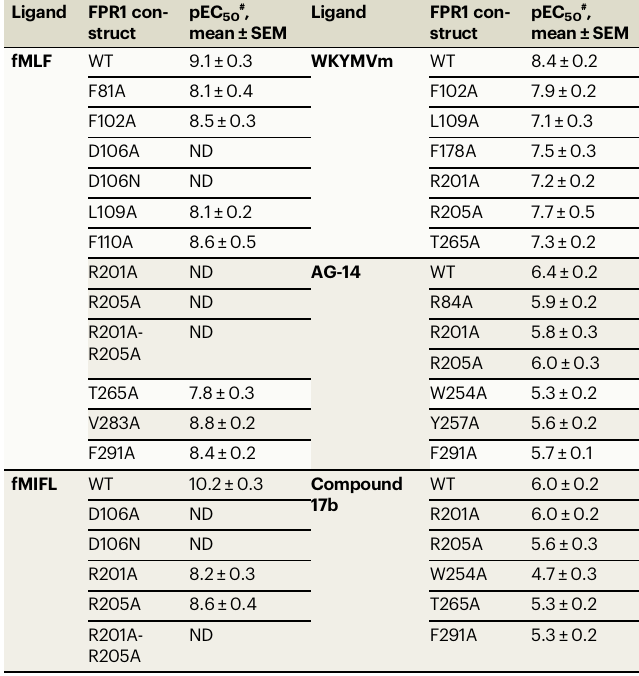
Table. 1 | cAMP responses of WT FPR1 and its mutants to selected agonists Ligand FPR1 con- pEC 50 # , struct mean±SEM